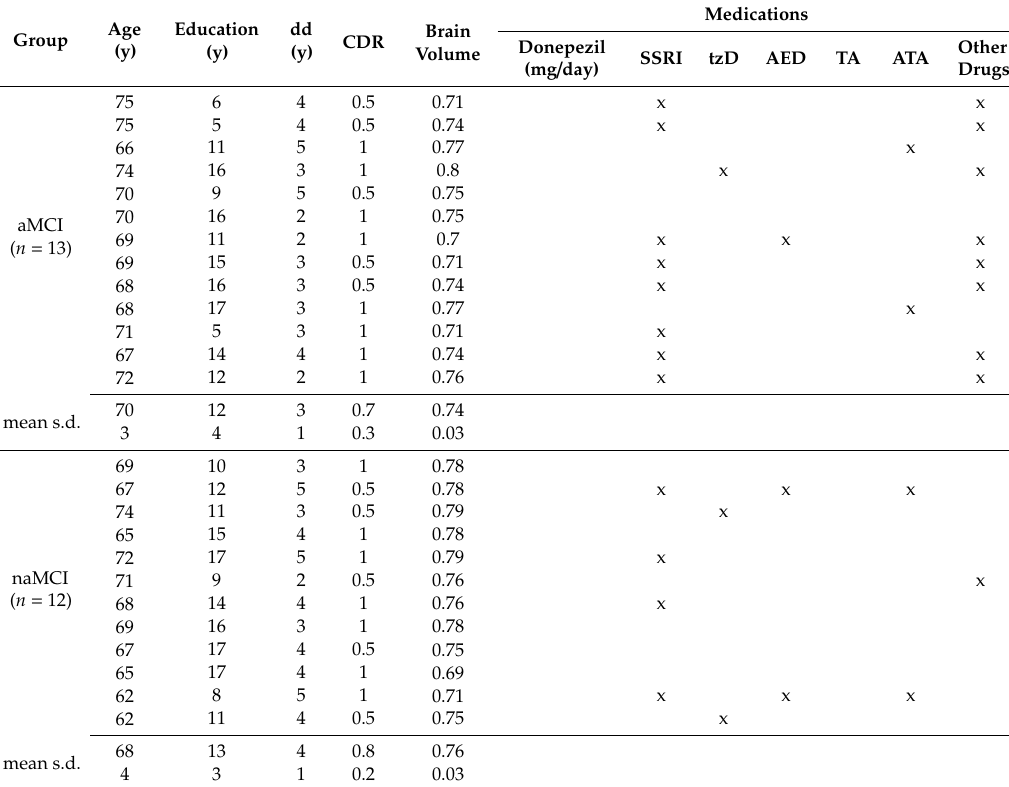
Table 1. Clinical-demographic characteristics. Legend: CDR Clinical Dementia Rating scale; dd disease duration; brain volume measure is reported as the percentage of intracranial volume; AD Alzheimer disease; VaD vascular dementia; MCI Mild Cognitive Impairment; an amnestic MCI; na non-amnestic